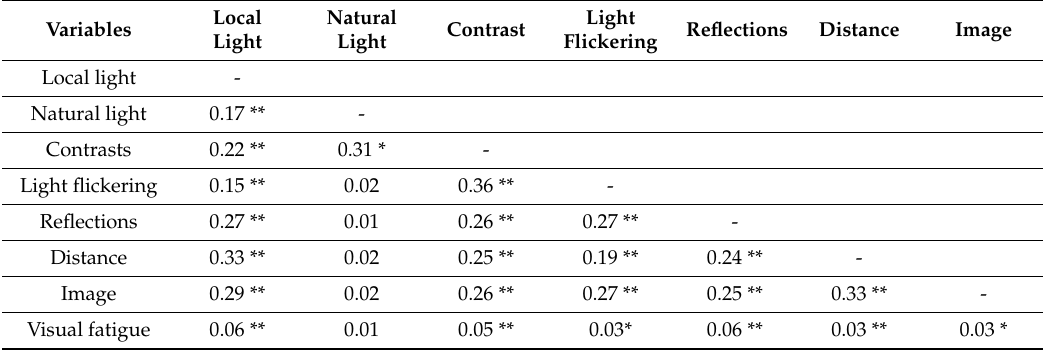
Table 2. Pearson’s correlation between visual fatigue and environmental variables .